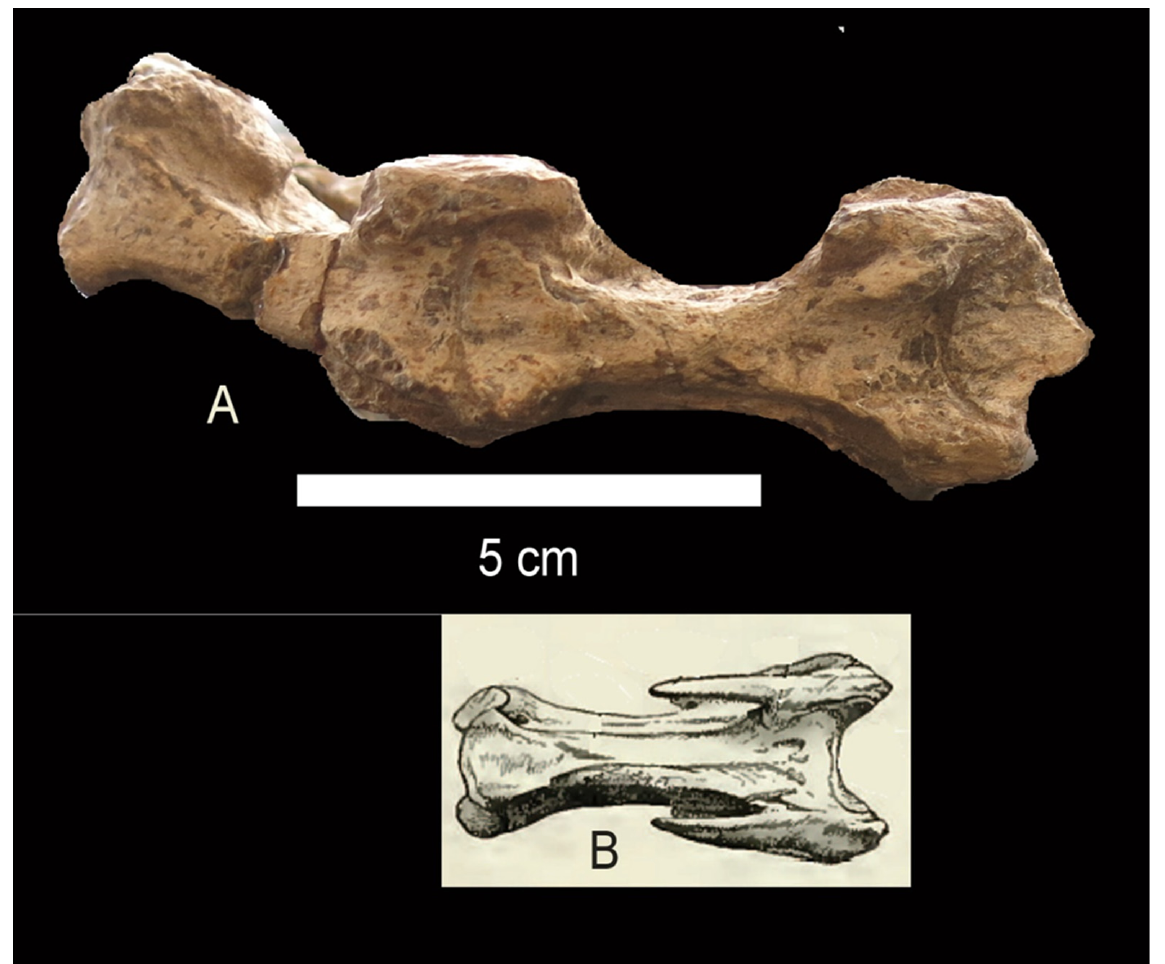
Figure 3. The three anteriormost elements of the series of cervical vertebrae of the type specimen of Struthio asiaticus Milne-Edwards, 1869–1871, NHMUK PV OR 23105, in ventral view ( A ). Only the posterior end of the anteriormost vertebra is preserved at the right end of the series. According to Davies [3] these are the 5th to 7th vertebrae. ( B ) 6th cervical vertebra of Struthio camelus (not to scale) for comparison, after Mivart [26].